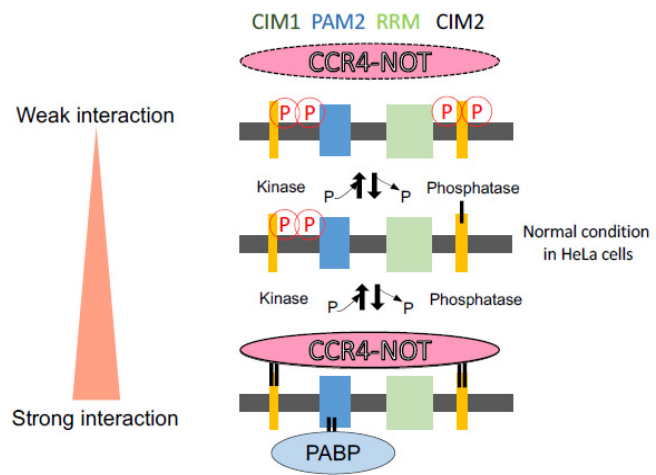
Figure 5. Possible regulation by the phosphorylation in the SD region of TNRC6A of the interaction with RNA silencing related-factors. In HeLa cells, two serine residues (S1332, S1346) close to CIM1 were phosphorylated, and two serine residues (S1616, S1691) close to CIM2 were not phosphorylated. However, dephosphorylation of S1332 and S1346 enhanced the interaction with CNOT1, CNOT9, and PABP, and phosphorylation of S1616 and S1691 repressed their interactions. Thus, phosphorylation of these serine residues may inhibit the interaction with RNA silencing-related factors, and their dephosphorylation may enhance their interactions. Such interactions are considered to regulate RNA silencing activities.